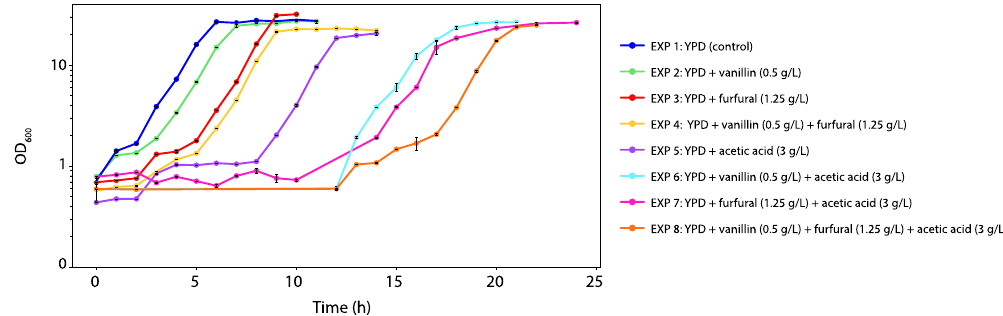
Figure 1. Growth profiles of Saccharomyces cerevisiae in the different experiments. The values plotted are the average of two replicates, and the error bars indicate the difference between the two replicates. This figure was produced using Python 70